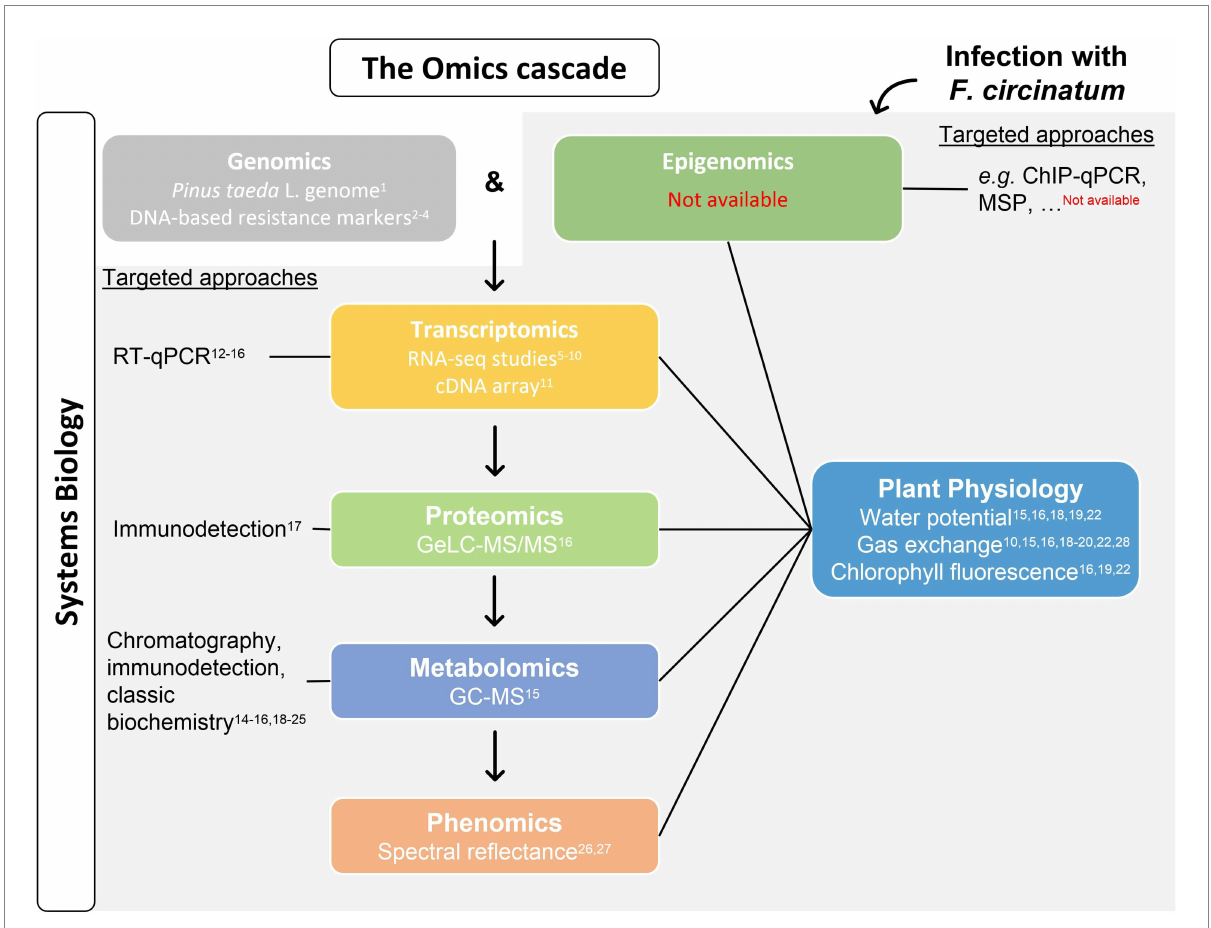
FIGURE 2 Advances and knowledge gaps on Pine pitch canker (PPC) research regarding the different levels of the Omics cascade. The availability of P. taeda genome is a useful tool for exploring Pinus - Fusarium circinatum interaction and allowed to identify DNA markers that determine the resistance of a certain genotype to PPC. In addition, F. circinatum infection induces changes at the DNA, RNA, and protein and metabolite levels, ultimately resulting in different phenotypes (grey background). While epigenetic studies were not performed on PPC, several transcriptomics studies included hosts with different susceptibilities and overtime analysis near the inoculation point. The single proteomic and metabolomic analyses available were performed using needles of pines with contrasting responses to F. circinatum infection. Phenomics studies are also available. Changes on the abundance of putative transcripts, proteins, and metabolites of interest have been explored and may complement/validate Omics data together with plant physiology measurements. The integration of this data provides a systems biology view of pine response to